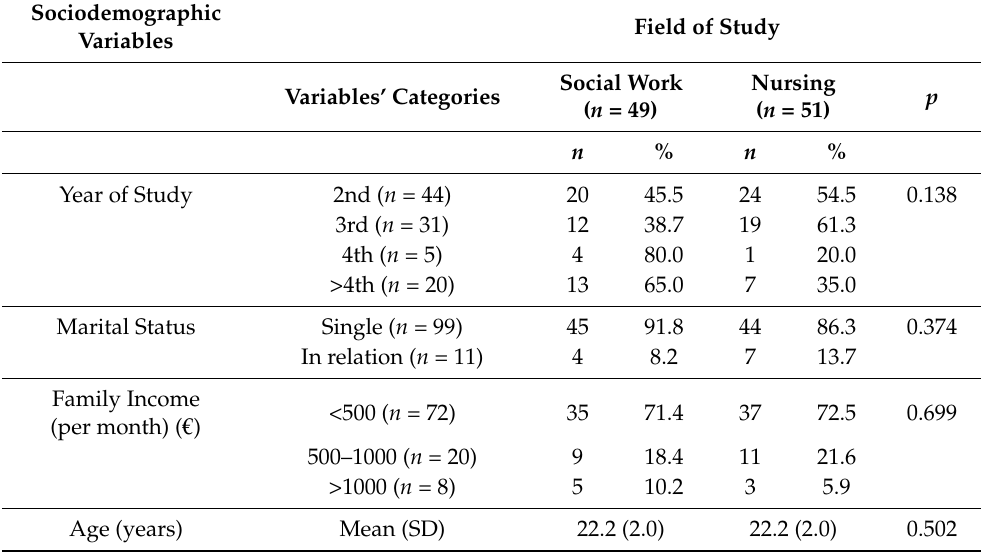
Table 1. Sociodemographic characteristics of the sample by field of study.